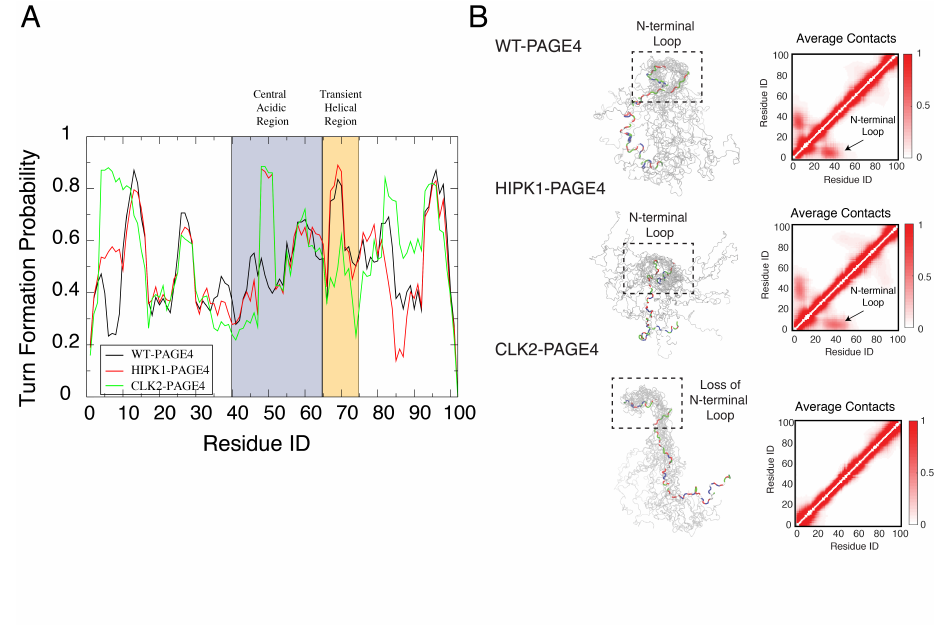
Figure 3. Orderly features behind the disordered PAGE4 ensembles. ( A ) The probability for each residue of PAGE4 to adopt a turn-like structure upon different levels of phosphorylation. The central acidic region and transient helical region are shaded in blue and orange, respectively. The secondary structure was calculated using the Stride algorithm based on the simulated trajectories [78]. Phosphorylations stabilize the turn-like structure in the central acidic region of PAGE4, while hyper-phosphorylation decreases the degree of order in the transiently helical region. ( B ) ( Left ) Representative structural snapshots collected from our simulations generated by AAWSEM. Randomly picked structures are aligned to minimize the root-mean-square deviations (RMSDs) among their N-motifs [79]. ( B ) ( Right ) The average contact maps generated from the simulated ensembles. Contacts are defined as two residues in close spatial proximity to each other. The color bar shows the probability of contact formation . There are non-zero probabilities of contacts formed between the N-motif and the central acidic region in WT-PAGE4 and HIPK1-PAGE4 (indicated by arrows in plots), indicating a metastable structural loop formation in this region. Hyper-phosphorylation eradicates this loop formation in the CLK2 form. Reproduced from [35] with